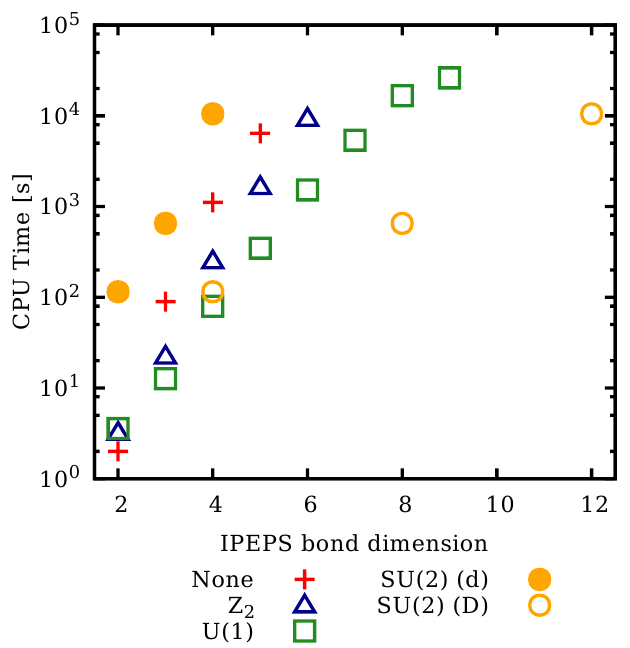
Figure 2: Computational effort for CTM initialisation, energy evaluation and five FFU steps in imaginary time in the Heisenberg square lattice model. Data for the SU ( 2 ) - symmetric calculation is plotted over the reduced ( d ) and total ( D ) bond dimension.